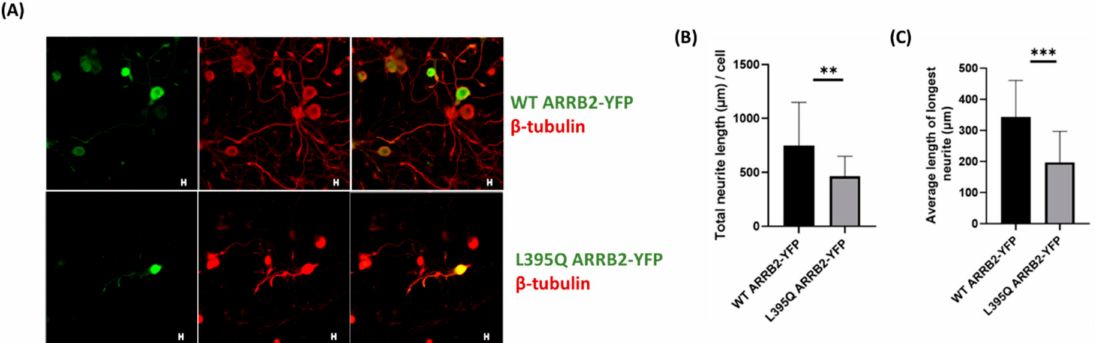
Figure 7. ARRB2 nuclear localization decreases neurite outgrowth in DRG neurons. ( A ) Representative confocal image of cultured DRG neurons transduced with WT ARRB2-YFP or L395Q ARRB2-YFP, and immunostained for ß-tubulin. Neurite branching and length were determined using ß-tubulin immunostaining and quantification by ImageJ ( B , C ). Scale bars, 10 µ m; ** p < 0.01; *** p < 0.001 by Mann–Whitney U test. N = 40 images analyzed from three independent